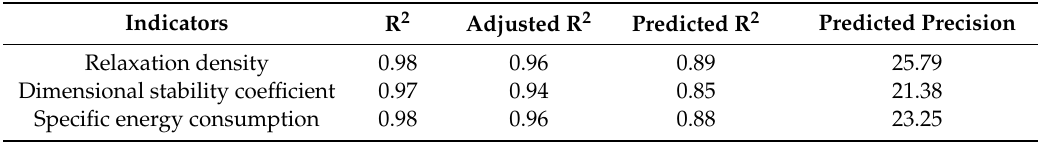
Table 5. Response model fit summary output for relaxation density, dimensional stability coe ffi cient and specific energy